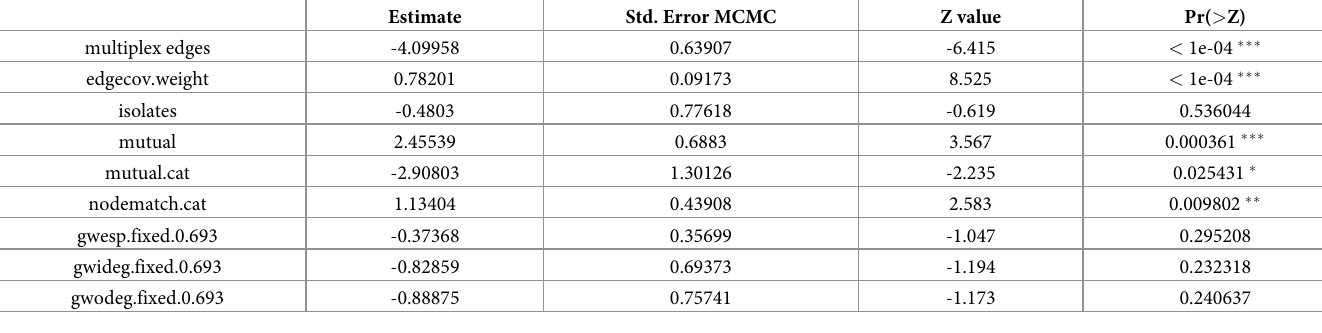
Table 6. Multiplexity in the alpha community [24].